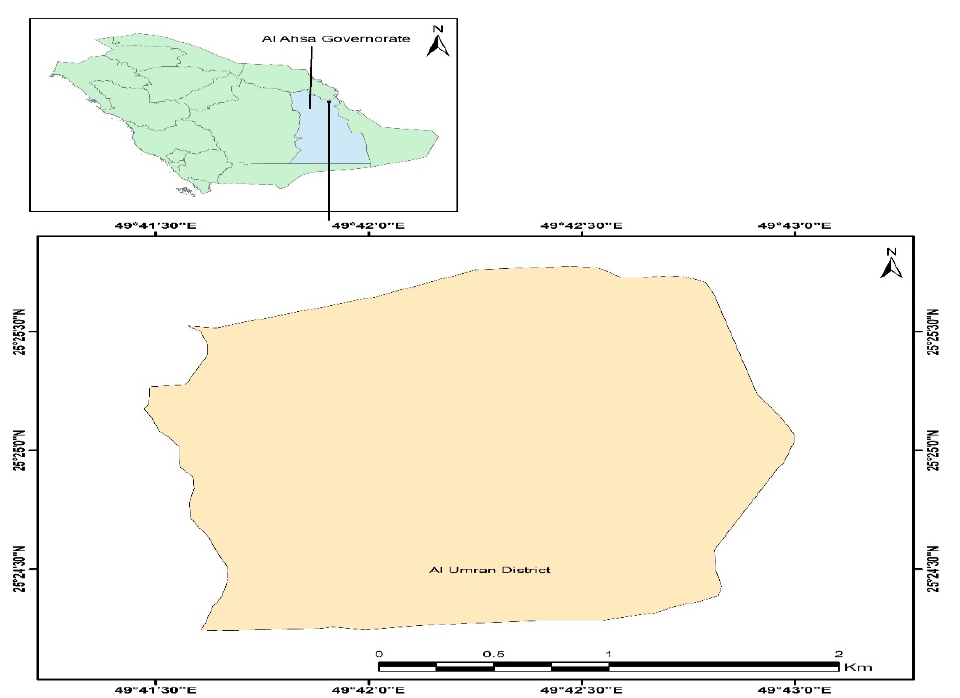
Figure 1. Map of study area. Source: Kassem, et al.